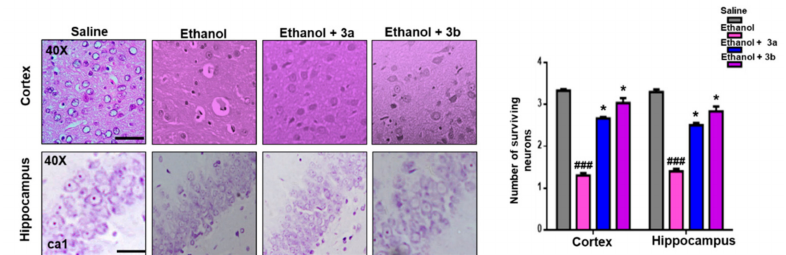
Figure 4. Representative immunohistochemical images of hematoxylin and eosin (H&E) and the quantified histogram of the survival neuron reactivity and integrated density in the cortex and hippocampus region of the adult cortex. The expressed data are relative to the control. ### shows significantly di ff erent from the control; ∗ shows significantly di ff erent from the ethanol-treated group.